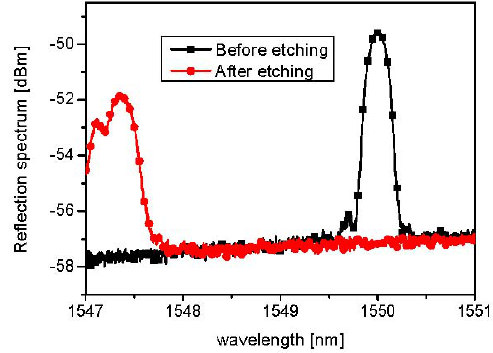
Figure 4. Measured Bragg wavelength before and after the cladding-etching